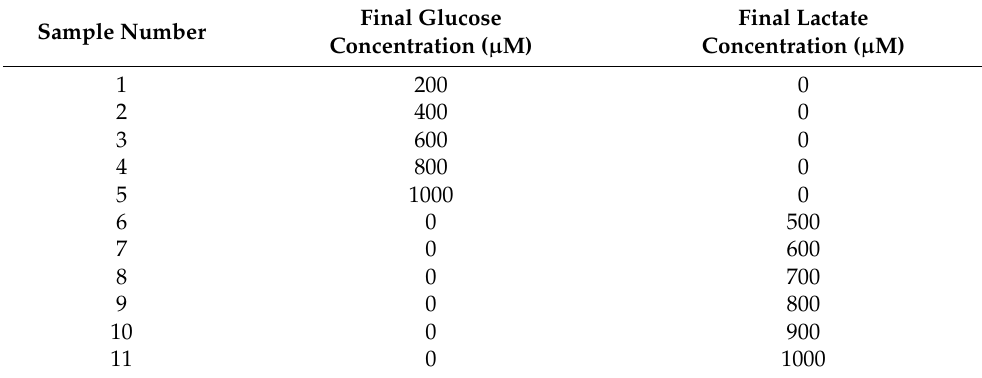
Table 1. The spiking concentrations of the tested human saliva